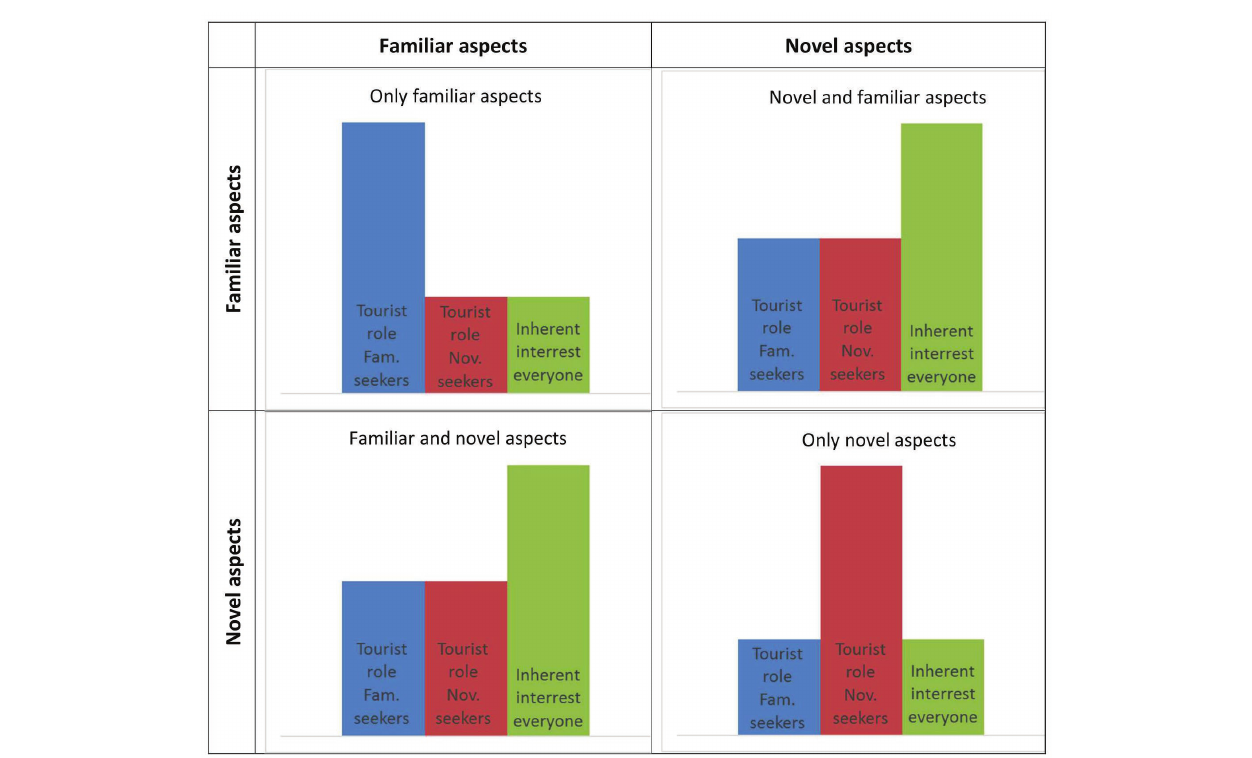
FIGURE 1 | Predictions of interestingness by tourist role theory and interaction